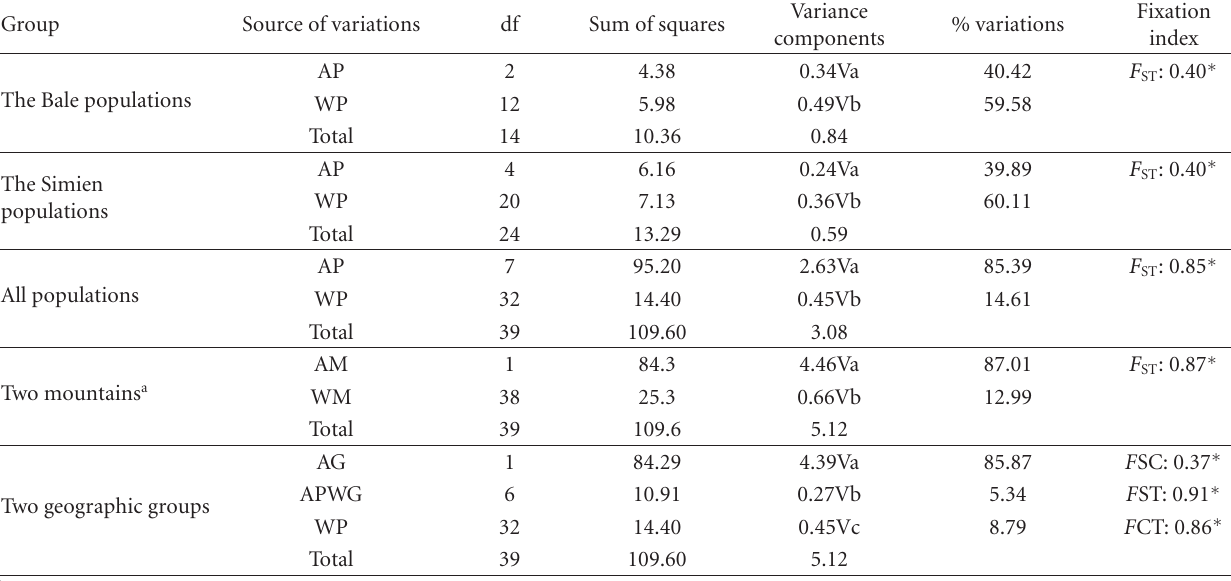
Table 3: Analysis of molecular variance (AMOVA) at di ff erent levels based on the Kimura K2P distance method. Group Source of variations df Sum of squares